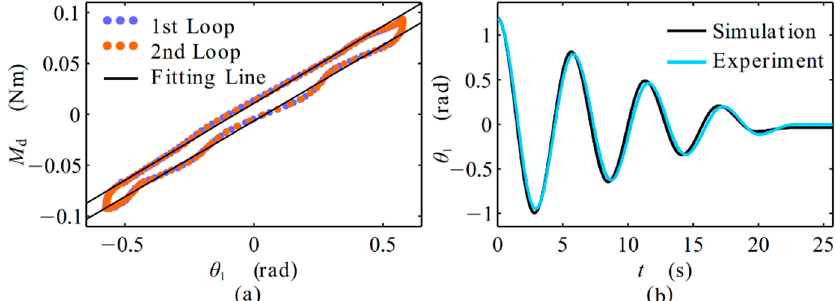
Figure 6. Parameter identification results with spring 1 active: ( a ) excited quasi-static low-frequency oscillation; ( b ) free oscillation after initial displacement.